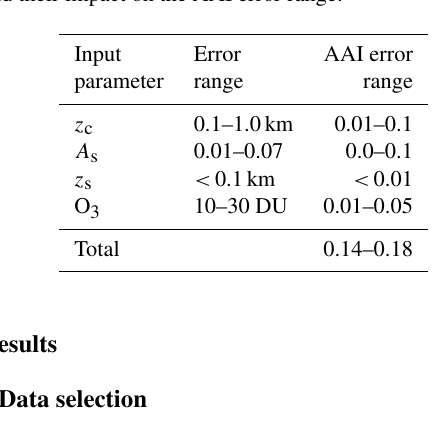
Table 2. Error range estimates for the AAI retrieval input parame- ters and their impact on the AAI error